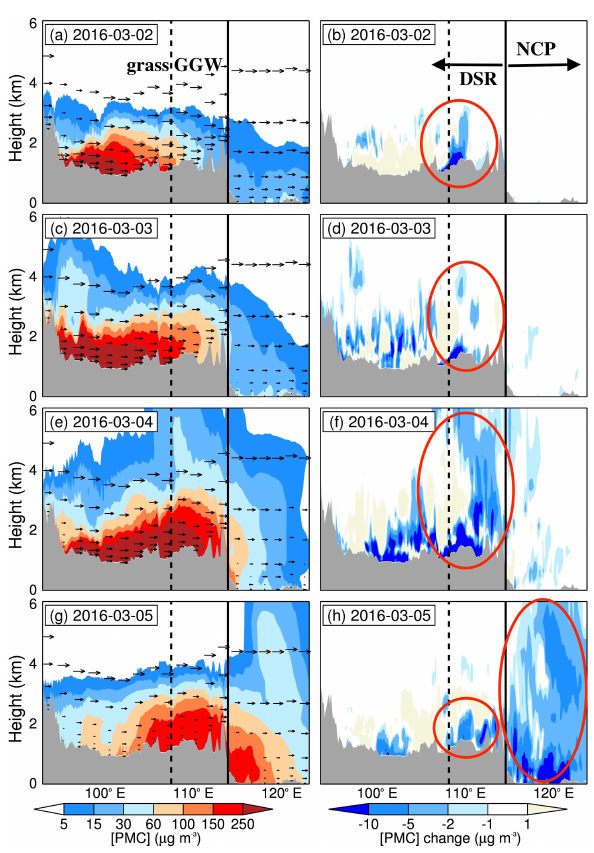
Figure 9. Panels (a, c, e, g) show the vertical profiles of daily [PMC] and winds along the cross section (see Fig. 1) for the REF case. Panels (b, d, f, h) show the vertical profiles of daily [PMC] change between the REF case and the SEN-ERPs case (REF – SEN- ERPs). The dark dashed and solid lines denote the X and Y points in Fig. 1b,